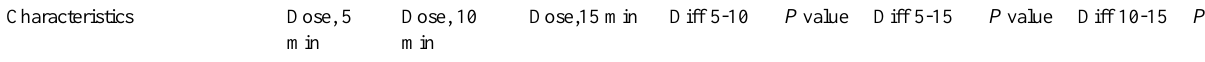
Table 3. Effect of the dosage of Tension Tamer app on sleep measures within ethnic groups (adjusted means with